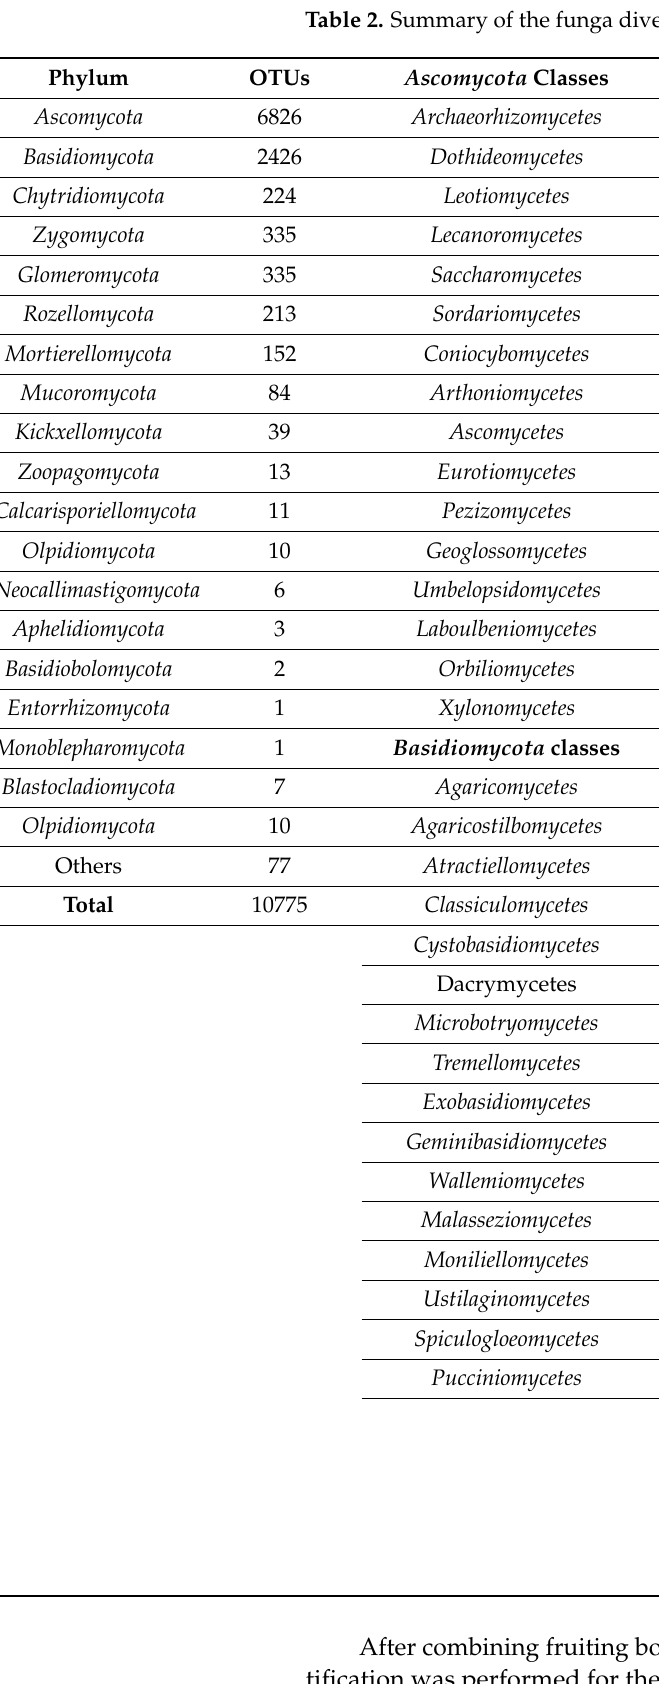
Table 2. Summary of the funga diversity in